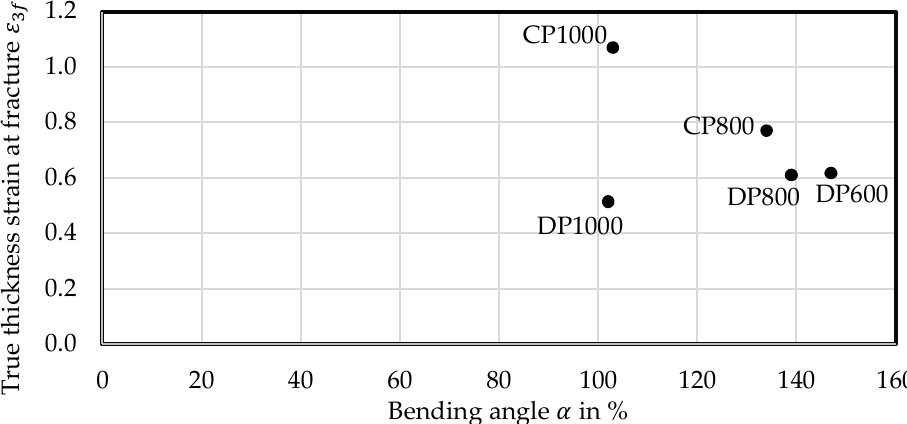
Figure A5. Local formability: No correlation between true thickness strain at fracture (cid:2013) (cid:2871)(cid:3033) and bending angle (cid:2009) according to VDA 238-100 [23]. Table A18. Micrographs of bending specimens (LD: Load drop, PD: Punch displacement).